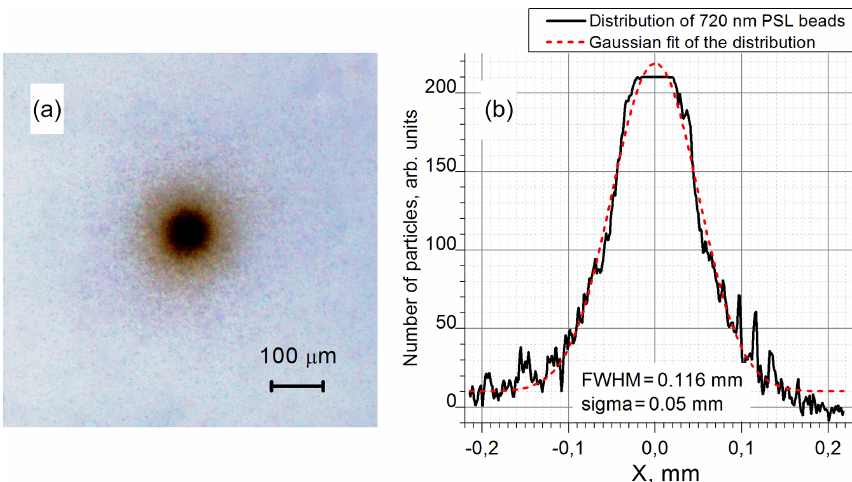
Figure 5. The distribution of 720nm particles collected on the glass plate without electrical field. (a) Photo of the spot from particles collected on the glass plate. (b) The density profile extracted from (a) by ImageJ software and the Gaussian approximation of the